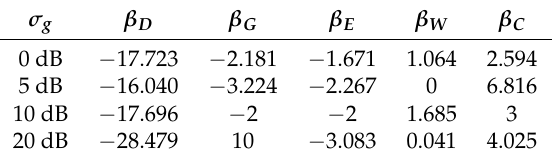
Table 2. Optimal parameter configurations of the MLM model for different values of σ g . σ g β D β